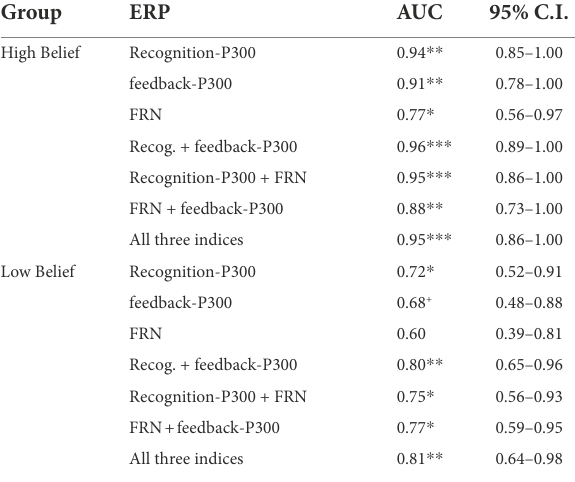
TABLE 3 AUCs and accuracies of various measures of ERP components. Group ERP AUC 95% C.I.